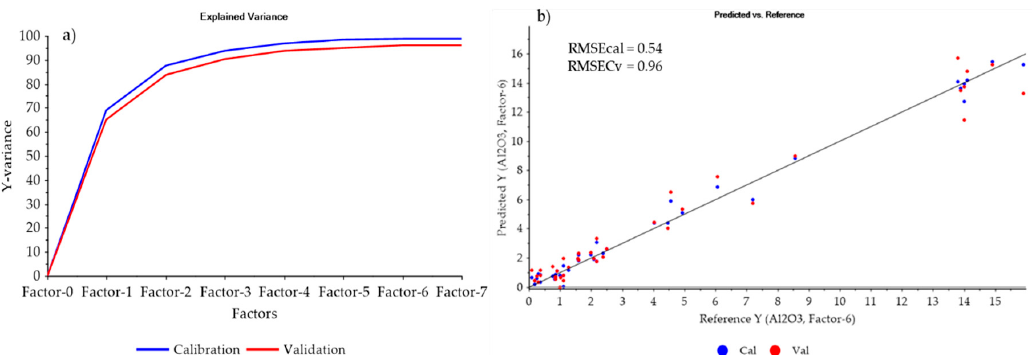
Figure 6. PLS regression results based on the dataset formed by low-level fusion of the normalised MWIR and LWIR data blocks for predicting Al 2 O 3 concentrations ( a ) the explained variance ( b ) the predicted vs. actual concentration for the calibration (RMSEcal) and cross-validation (RMSEcv) models.